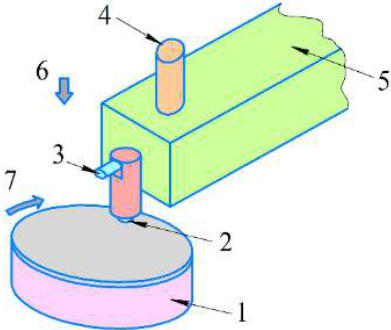
Figure 1. Scheme of the experiment. 1—disk with coatings, 2—steel ball, 3—AE sensor, 4—accel- erometer, 5—tribometer, 6—normal load, 7—sliding